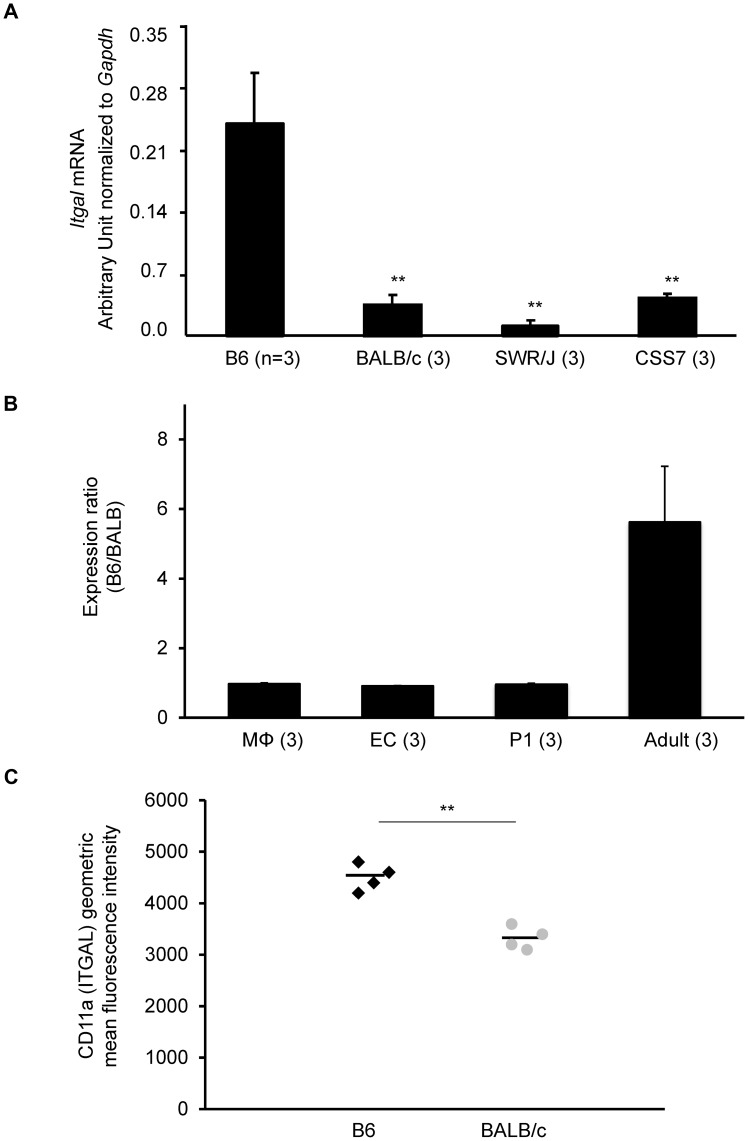
The strain-specific difference in Itgal message level is determined by cis-acting elements at the Civq1 locus.A. mRNA levels of the canonical isoform of Itgal (Itgal-002) in adult cortex from B6, BALB/c, SWR, and CSS7 strains as determined by qRT-PCR. Each bar represents mean ± SEM. ** P<0.001 vs. B6. B. The allele-specific expression ratio of Itgal transcript (Itgal-002) levels in F1 (B6×BALB) mice. A coding SNP (rs107634043) in exon 30 was used to monitor the B6-allele and BALB/c-allele transcripts of Itgal in macrophages (MΦ), endothelial cells (EC), P1 and the adult cerebral cortices. The level of the B6-specific Itgal transcript was approximately 6-fold higher than BALB/c-transcript in adult cortex. Each bar represents the allele-specific expression ratio (B6/BALB) averaged for three F1 animals. C. Surface expression of CD11a (ITGAL) on CD11a+ brain immune cells. CD45+ CD11a+ brain cells from BALB/c mice express significantly less surface CD11a as assessed by flow cytometric staining than B6 CD45+ CD11a+ brain cells (** P<0.001).